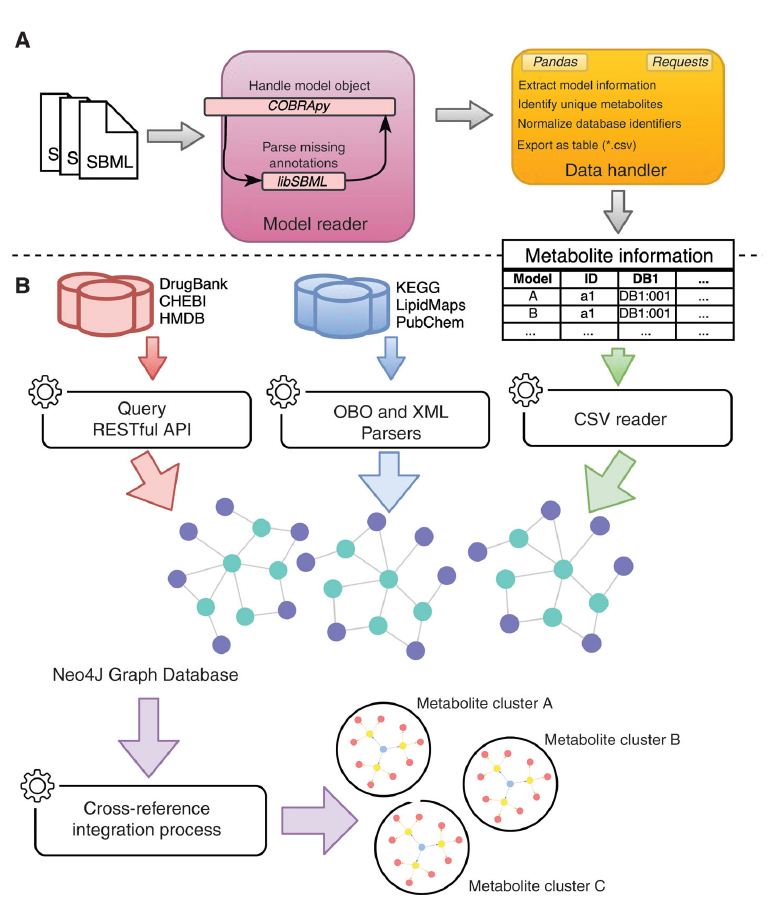
Figure 2: Representation of the data retrieval pipeline employed in this work. (A) Preprocessing metabolite information from the SBML files: the resulting table contains data for all metabolites of the used models. (B) Preprocessing